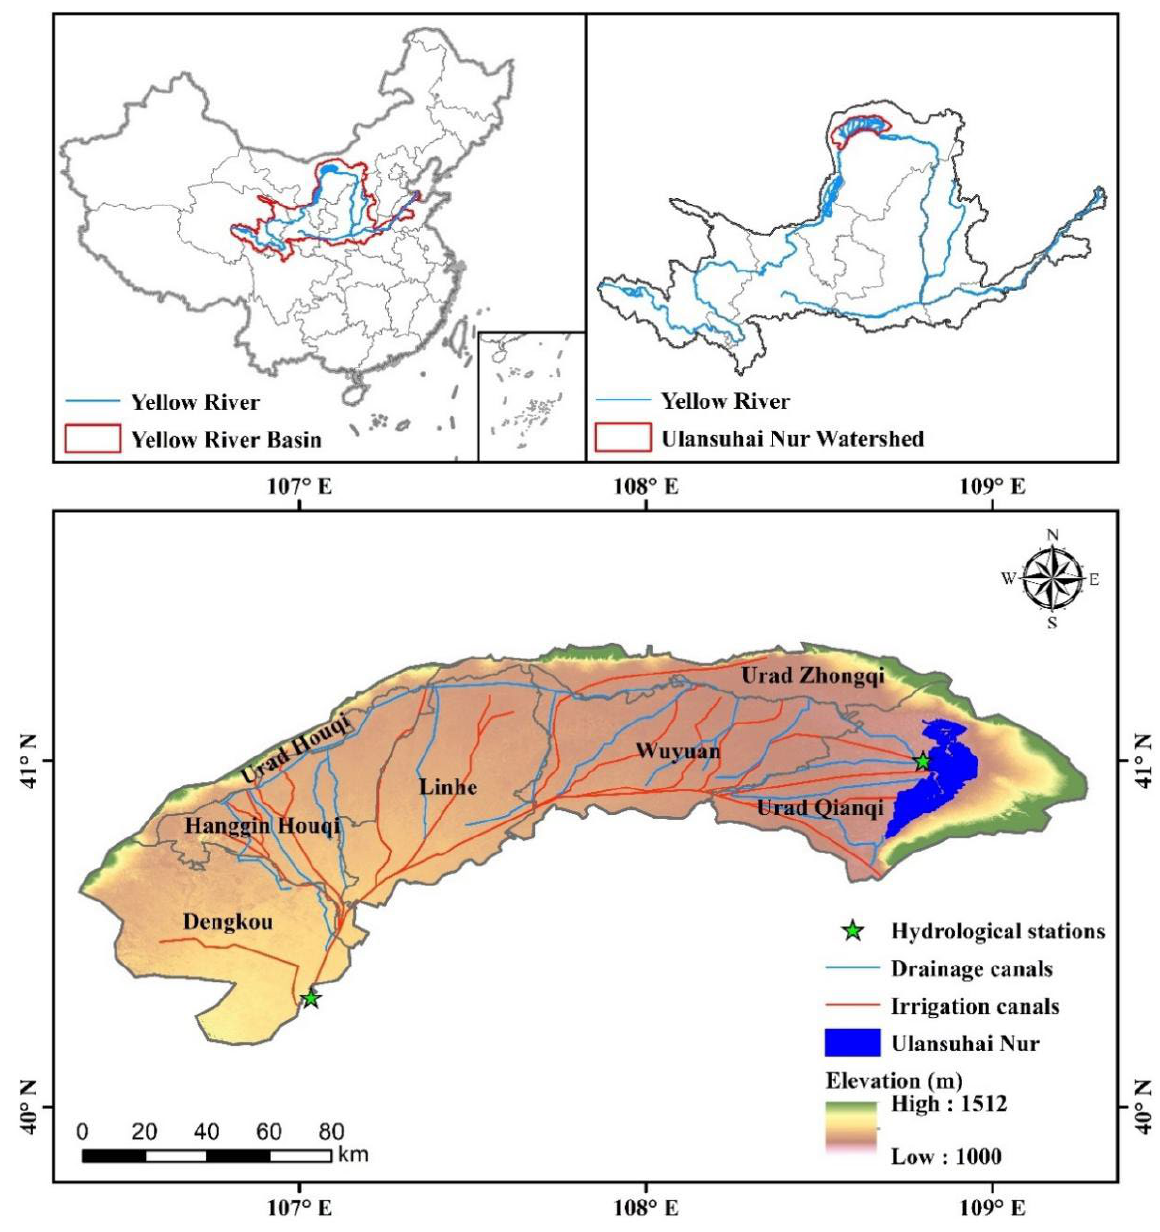
Figure 1. Geographical location of the UNW.